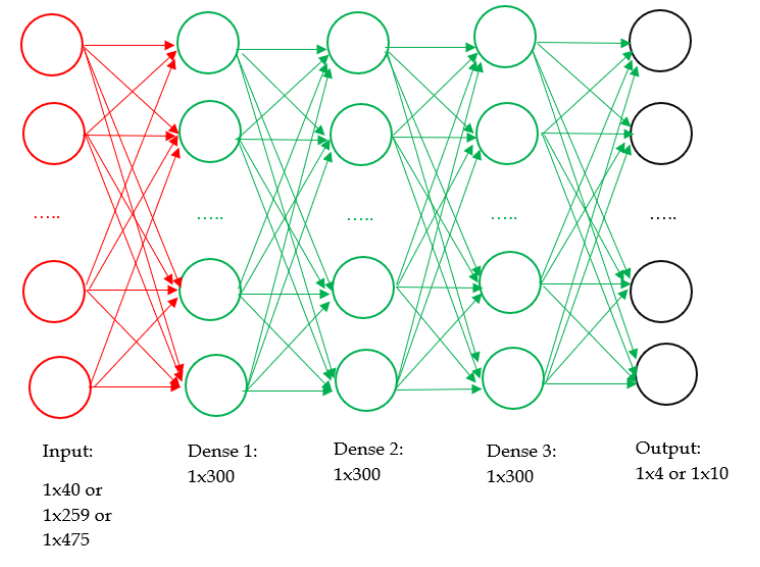
Figure 4. Architecture of the deep neural network used for aphasia